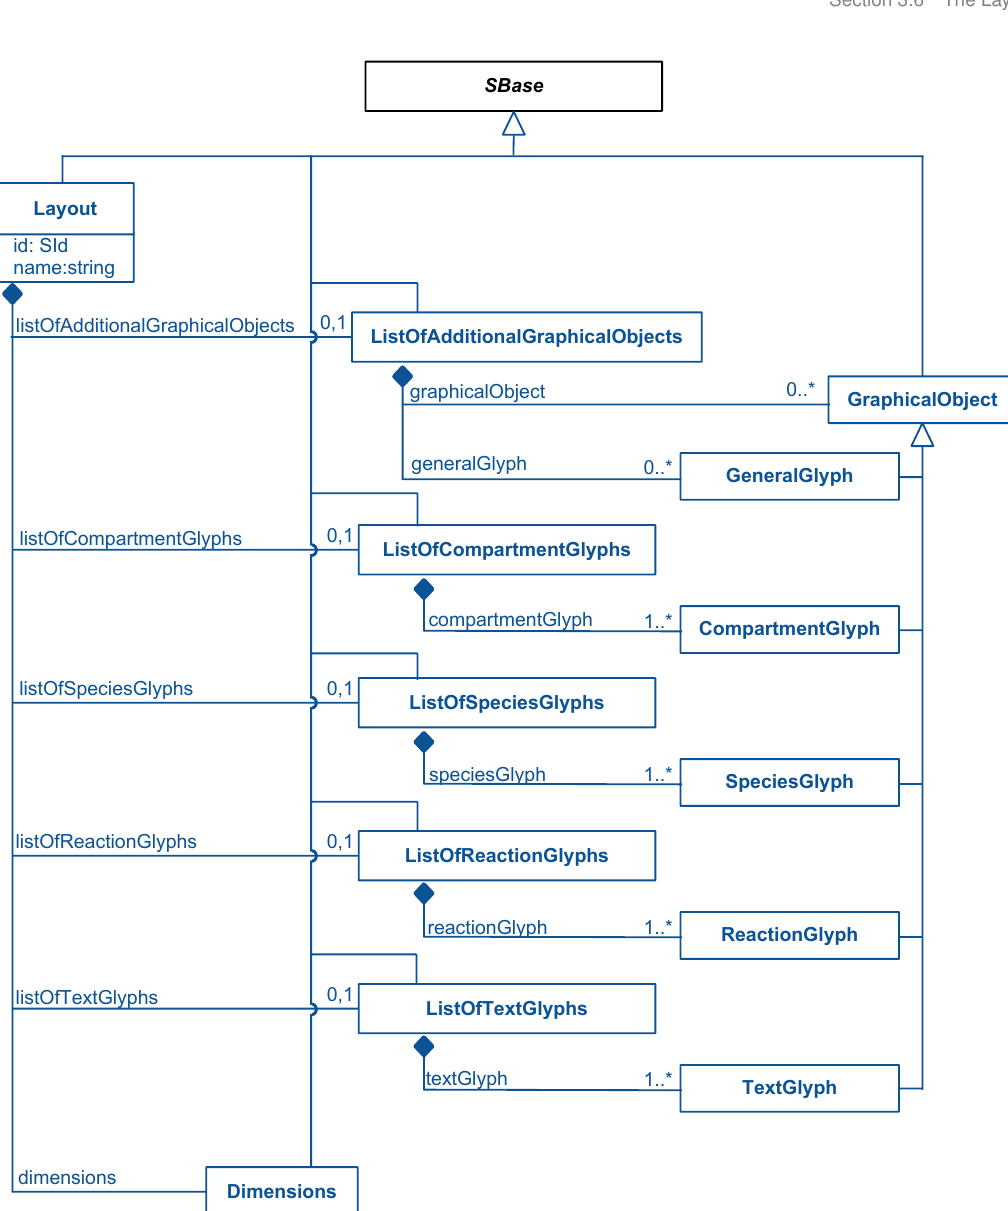
Figure 8: A UML representation of the Layout package . Derived from SBase , the classes of the Layout